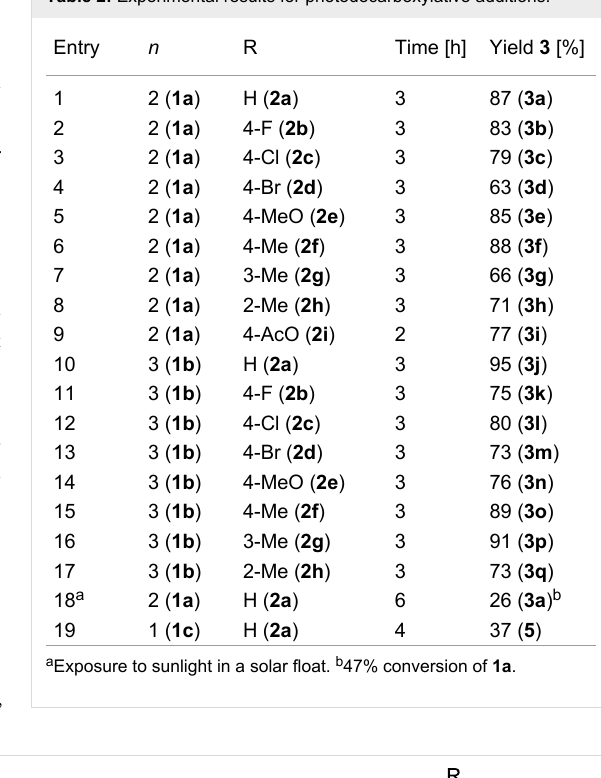
Table 2: Experimental results for photodecarboxylative